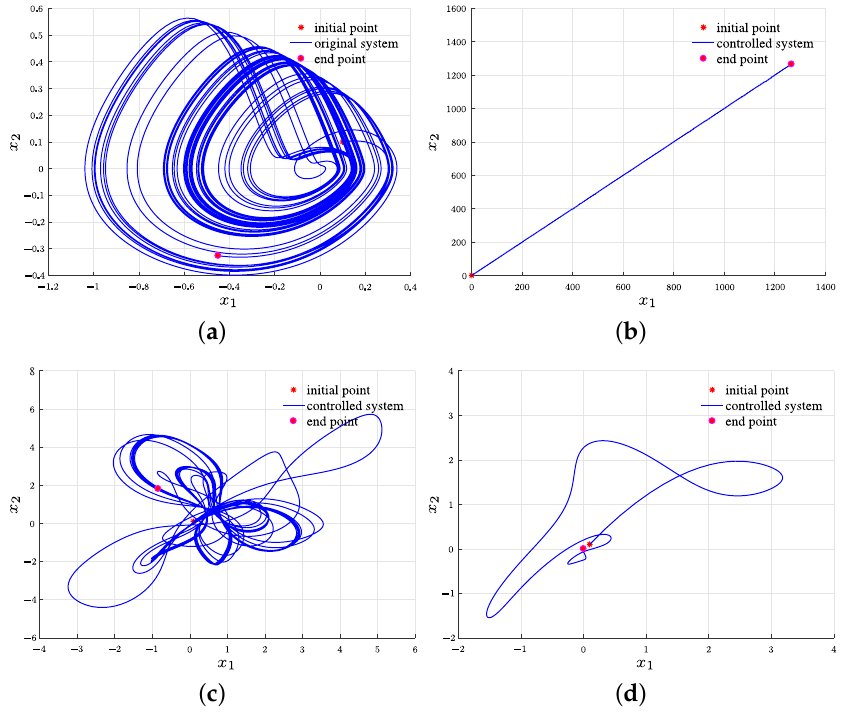
Figure 6. Phases of the original SFM system and the SFM under controller (40), controller (42) and controller (44) from X ( 0 ) = [ 0.1,0.1,0.1 ] T . ( a ) Original SFM system; ( b ) By controller (40); ( c ) By controller (42); ( d ) By controller (44).